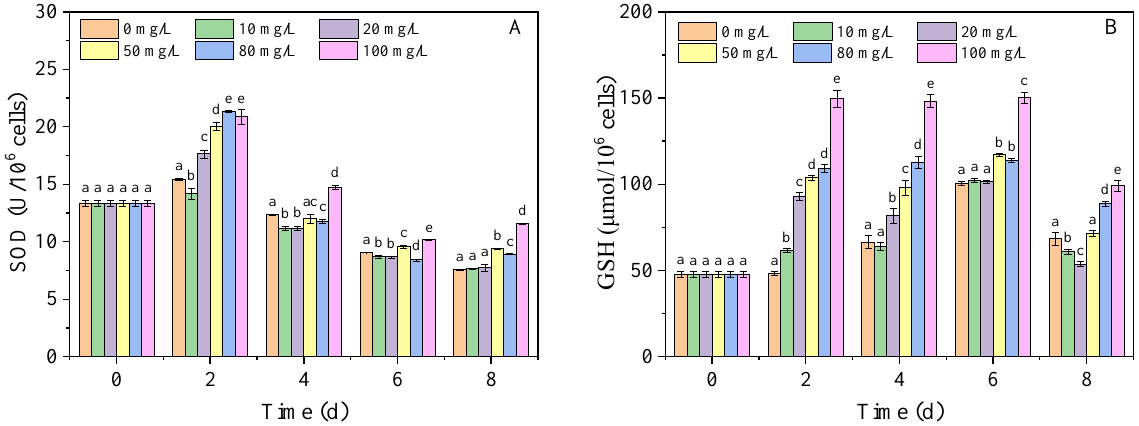
Figure 3. The SOD activity ( A ) and GSH content ( B ) of A. carterae in different concentrations of nano-PS groups. Different letters represent significant differences ( p < 0.05).